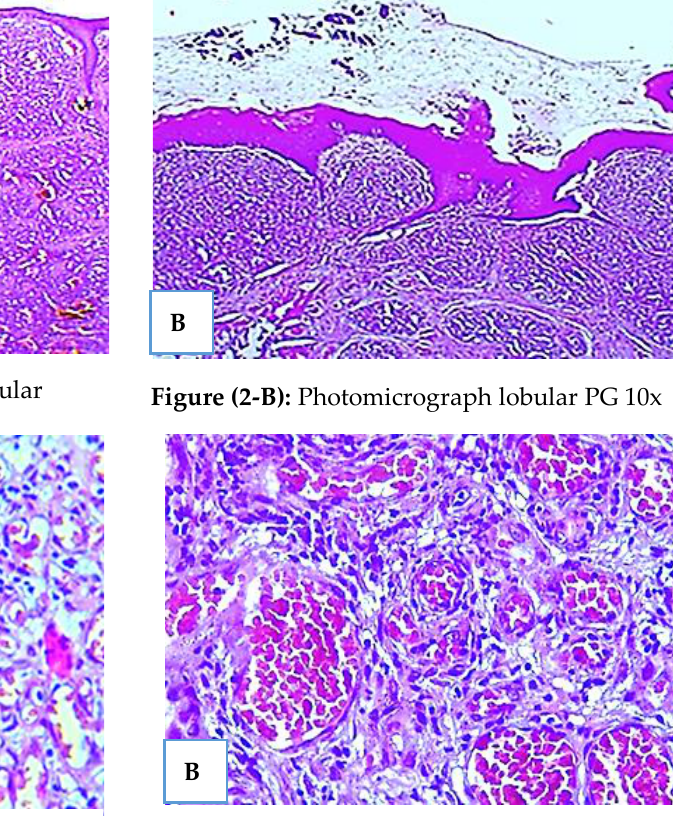
Figure (3-A): Photomicrograph lobular PG 40x